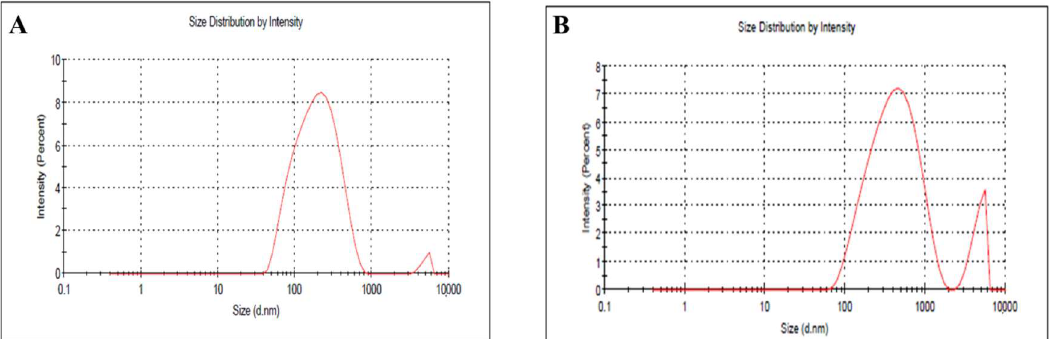
Figure 5. Particle size and PDI of ( A ) PEGylated PX-NE and ( B ) naked PX-NE.